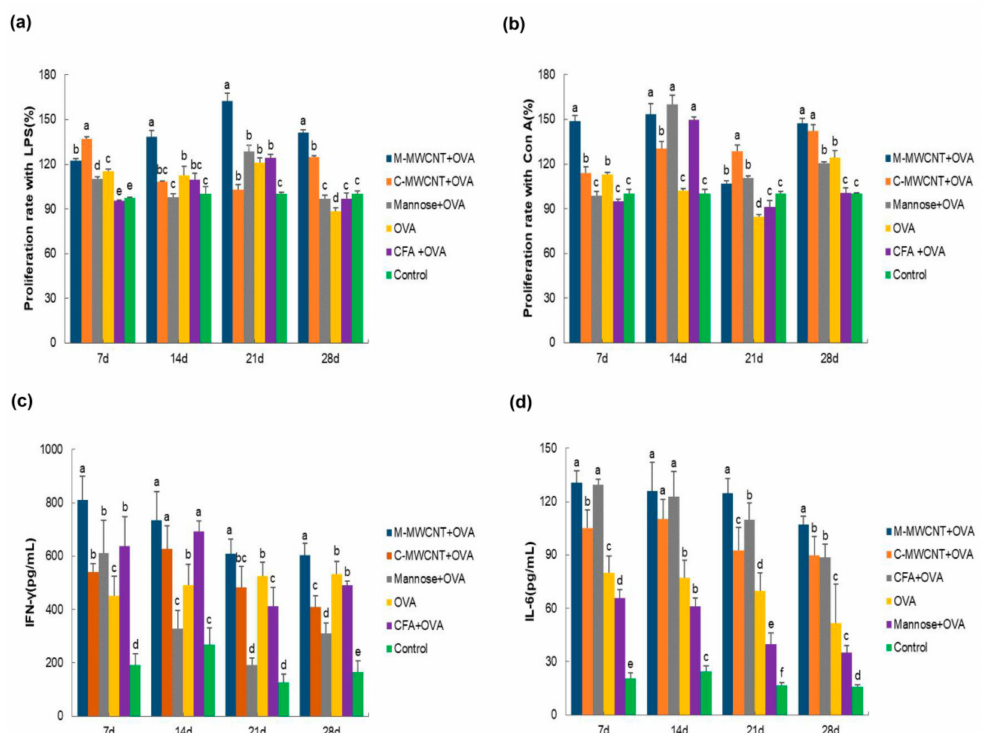
Figure 8. The M-MWCNT increased the proliferation of splenocytes and M-MWCNT the secretion of cytokines. The total splenocytes were isolated from the spleen of ICR mice in all groups on days 7, 14, 21, and 28 after the last immunization. The splenocyte proliferation rate ( a , b ) was estimated by the CCK-8 method. LPS and Con A, used as a mitogen, were co-cultured with splenocytes. The proliferation activity is represented as proliferation rate (%). The serum concentrations of IFN- γ ( c ) and IL-6 ( d ) in ICR mice were measured using ELISA. The data are presented as the mean ± SD ( n = 3) analyzed by one-way ANOVA and then Duncan’s multiple-range tests. Different letters (a–f) above each group of bars indicate statistically significant differences ( p <